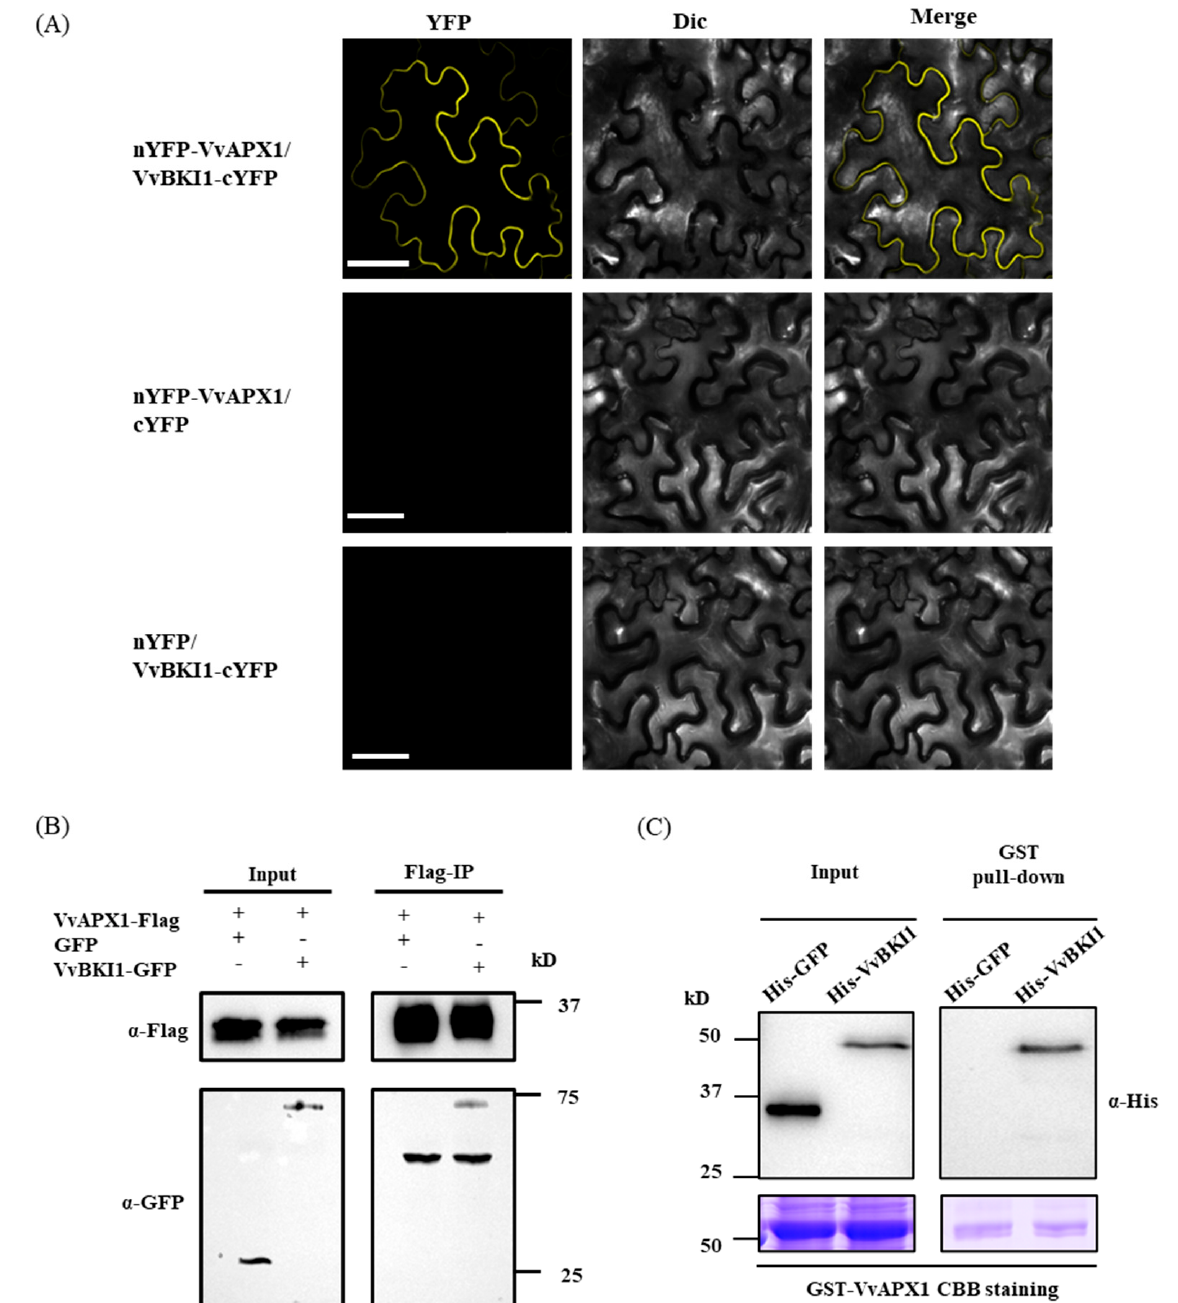
Figure 2. VvBKI1 interacts with VvAPX1 in vivo and in vitro. ( A ) BiFC assay indicates VvBKI1 interacting with VvAPX1 in vivo. nYFP-VvAPX1 and VvBKI1-cYFP was co-expressed for 48 h. Scale bar = 50 µ m. ( B ) CoIP assay indicates that VvBKI1 interacting with VvAPX1 in vivo. ( C ) Pull-down assay indicates that VvBKI1 interacting with VvAPX1 in vitro. His-GFP was used as negative control. The Coomassie brilliant blue (CBB) staining shows equal loading.